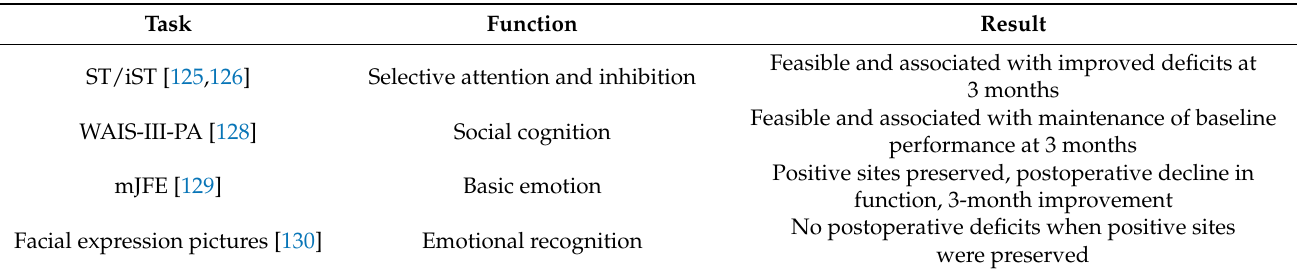
Table 3. Intraoperative tasks for assessing executive